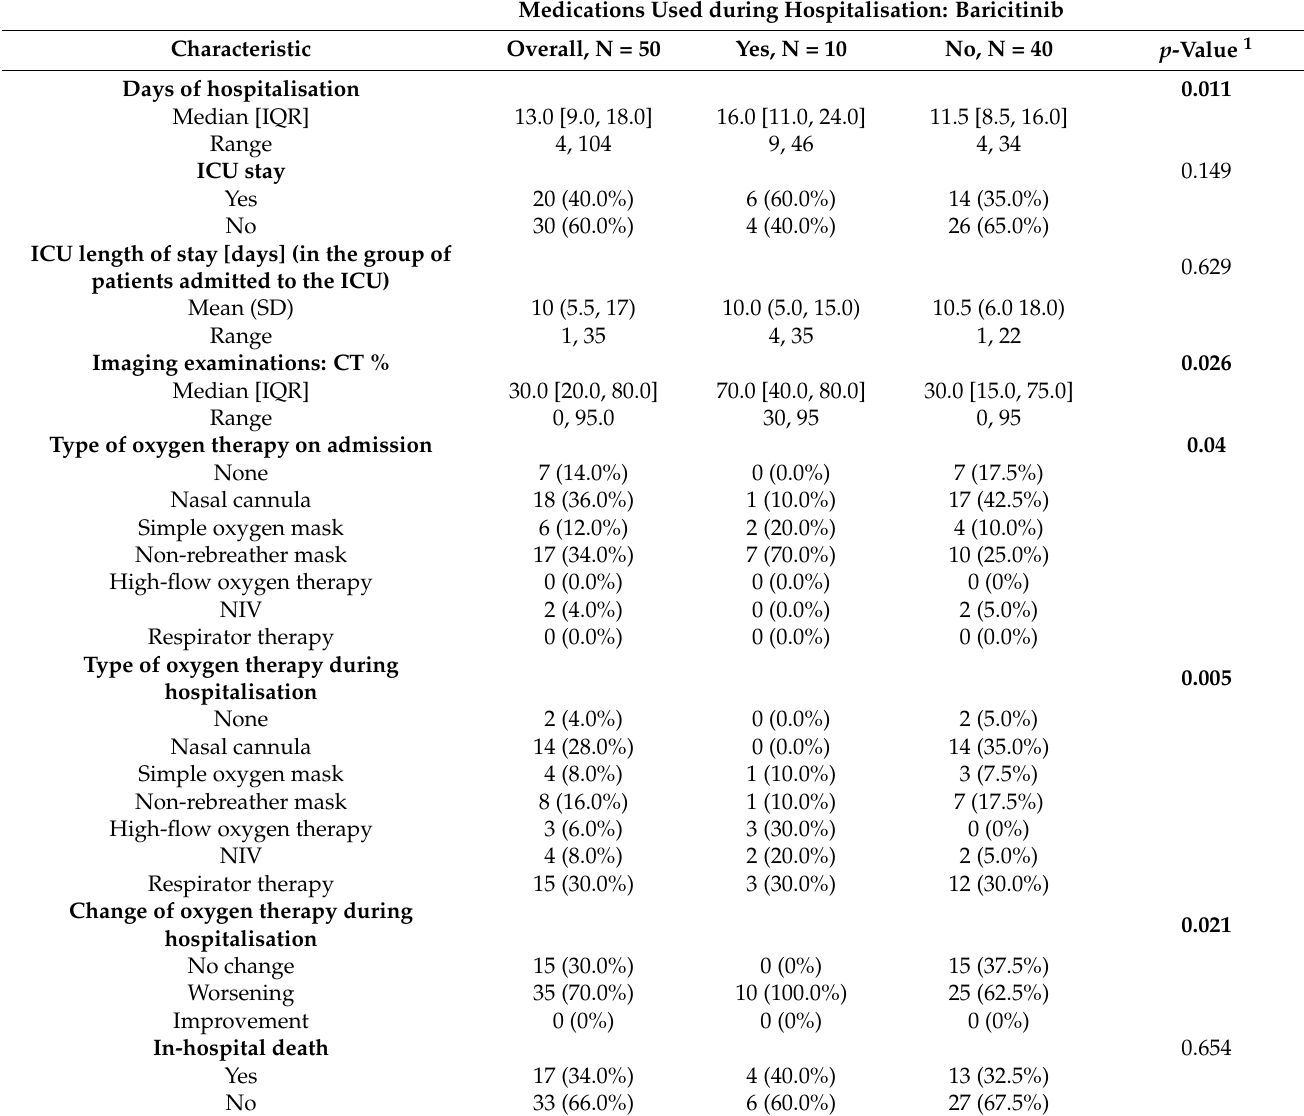
Table 9. Severity of COVID-19 vs. baricitinib medication, comparison between groups. Medications Used during Hospitalisation: